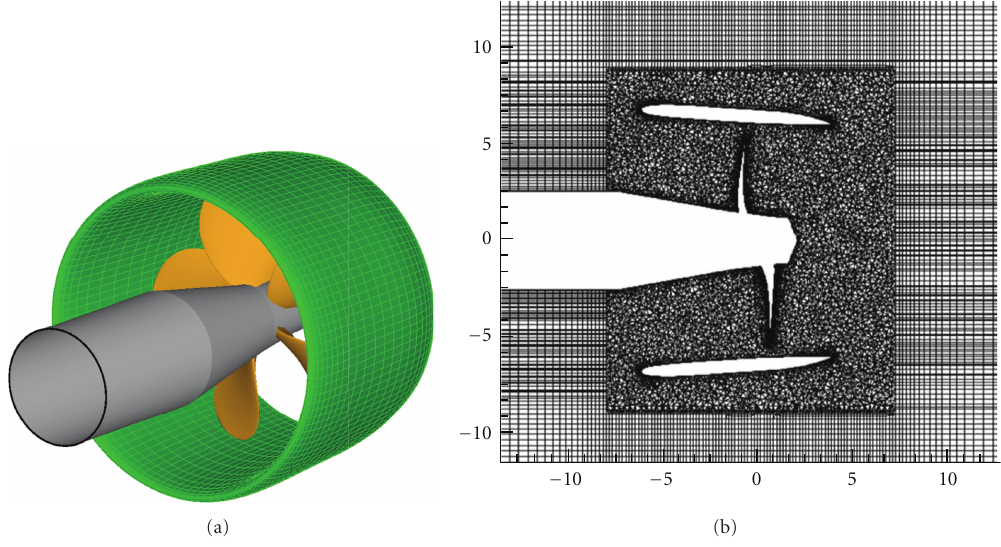
Figure 12: (a) Geometry of ducted propulsor without stator blades, (b) computational grid for the ducted